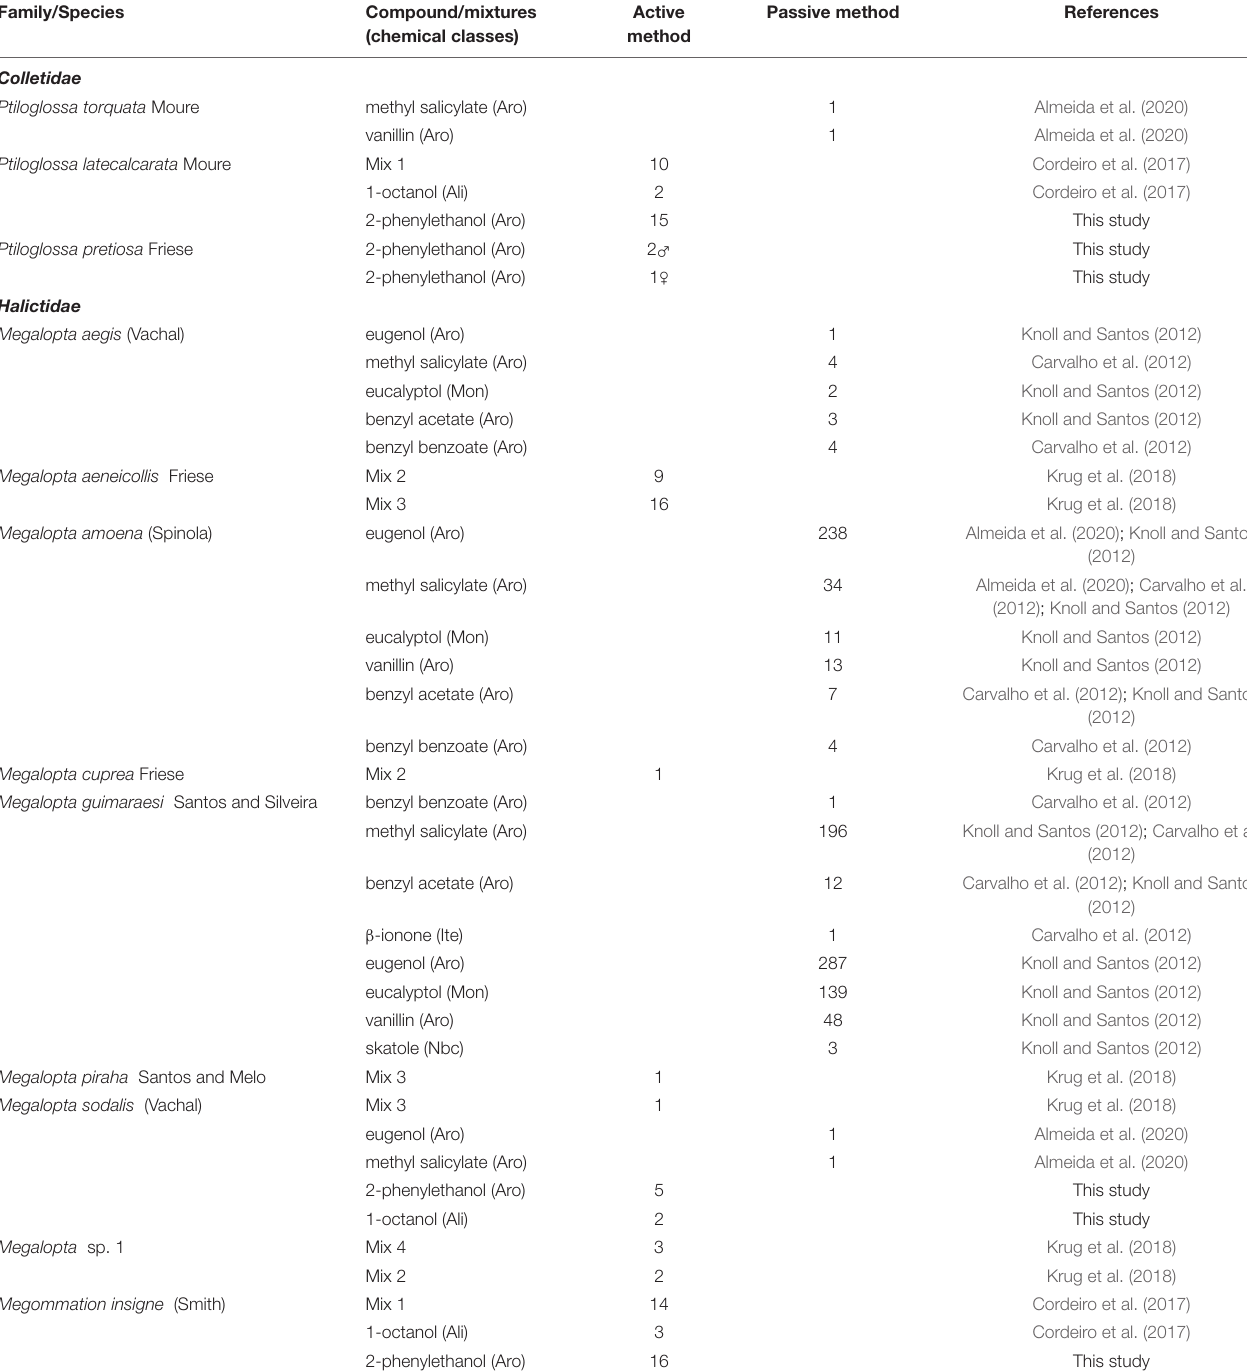
TABLE 1 | Number of individuals of nocturnal bee species lured with synthetic chemical compounds and collected with active and passive methods.